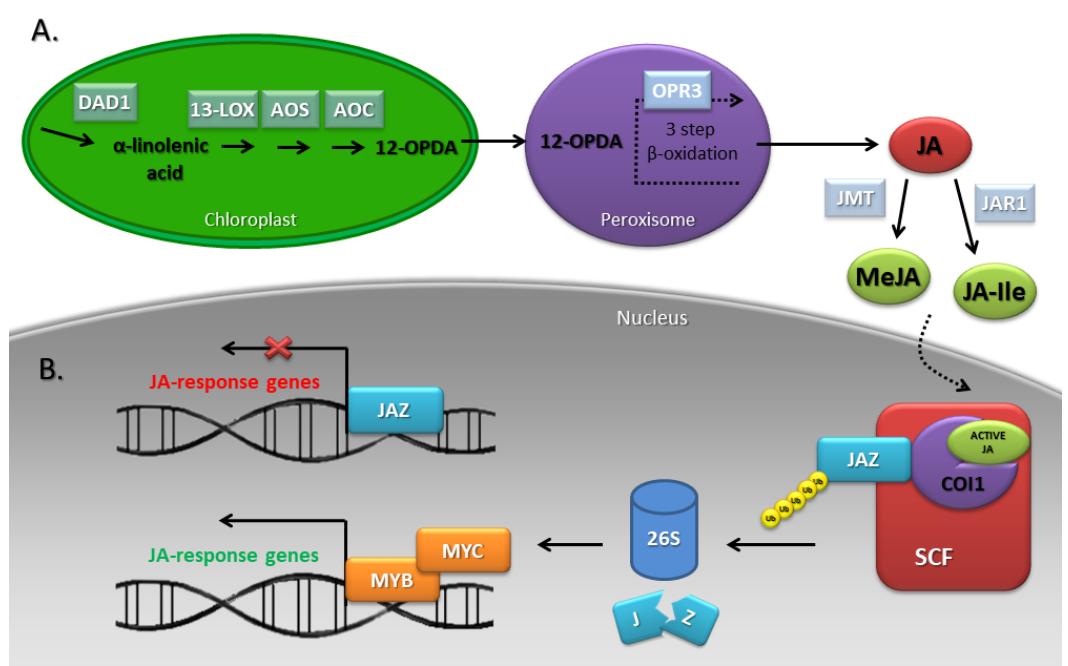
Figure 5. JA biosynthesis (A) and signaling (B) pathways. α-linolenic acid is released from membrane phospholipid by a lipolytic enzyme phospholipase A1 DEFECTIVE IN ANTHER